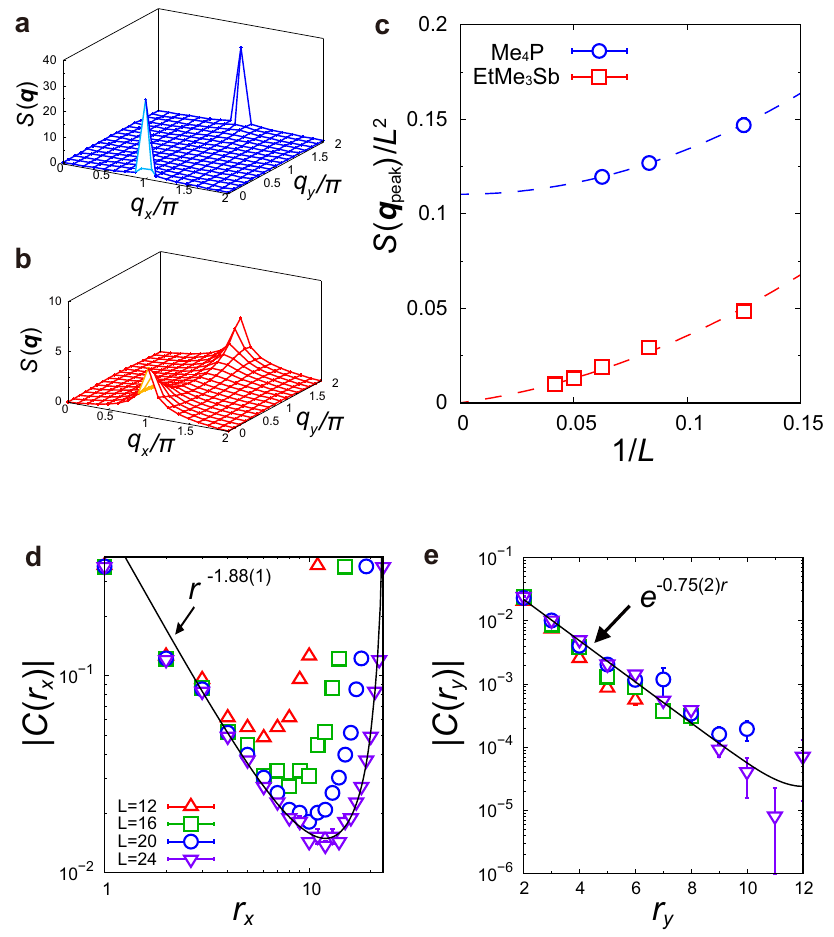
Fig. 3 Spin – spin correlation function C ( r ) and spin structure factor S ( q ) (Fourier transform of C ( r )) obtained by using the VMC method. a S ( q ) of the AF state for X = Me 4 P with L = 16 on a L × L lattice. b S ( q ) of the QSL for X = EtMe 3 Sb with L = 16. In ( a ) and ( b ), the unit of the momentum q x and q y is π . c Size dependences of the peak value of S ( q ) denoted as S ( q peak ) in the AF state for X = Me 4 P and the QSL state for X = EtMe 3 Sb. Dashed lines are guides for the eye. The AF state scales to a nonzero S ( q peak )/ N s in the thermodynamic limit, evidencing for the AF long-range order. On the other hand, extrapolation to zero in the thermodynamic limit for the QSL state con fi rms the nonmagnetic state. d Log – log plot of C ( r = ( r , 0)) for X = EtMe 3 Sb. Black thin line is the fi tting curve C fi t ( r ) ∝ ∑ n ∣ nL + r ∣ − p with n being integer by taking account of the antiperiodic boundary condition, which is fi t by p = 1.88 for L = 24. We use data points for 2 < r < L − 2 when we obtain the fi tting curve. P exp ð(cid:2)j nL þ r j = ξ ? Þ½ with ξ ⊥ = 1.33 for L = 24. Error e Semilog plot of C ( r = (0, r )) for X = EtMe 3 Sb. Black thin line is the fi tting curve C fit ð r Þ / n bars are obtained from the Monte Carlo sampling and the variance extrapolation, details of which are described in Methods. The length unit is the lattice constant in panels ( d ) and ( e ). In panels ( c – e ), error bars obtained in the VMC calculation are plotted and if not they are smaller than the symbol